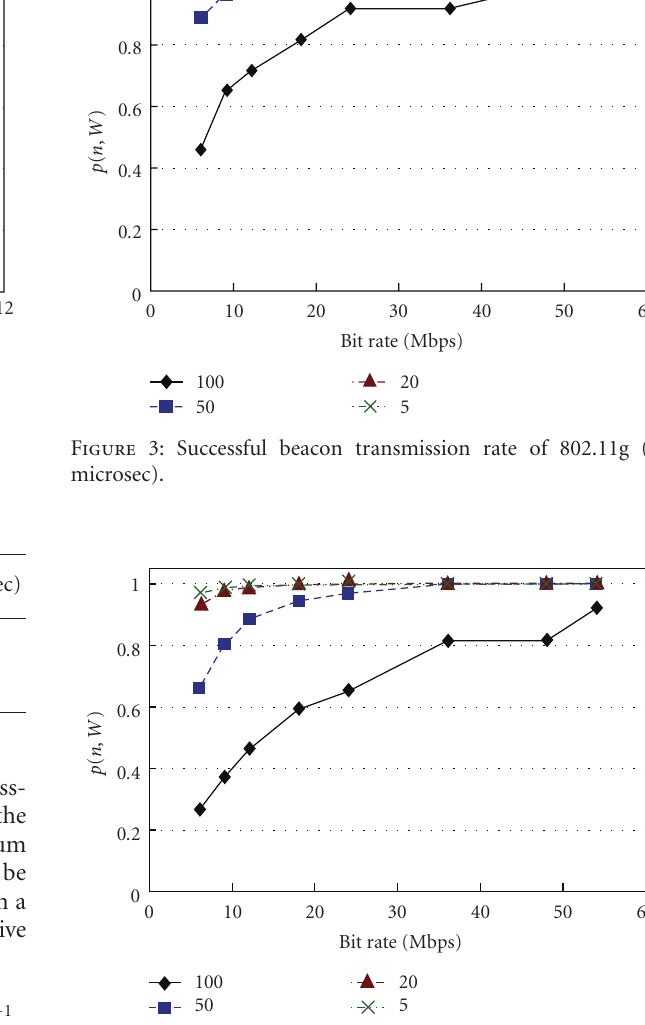
Figure 4: Successful beacon transmission rate of 802.11a/ pure g (9